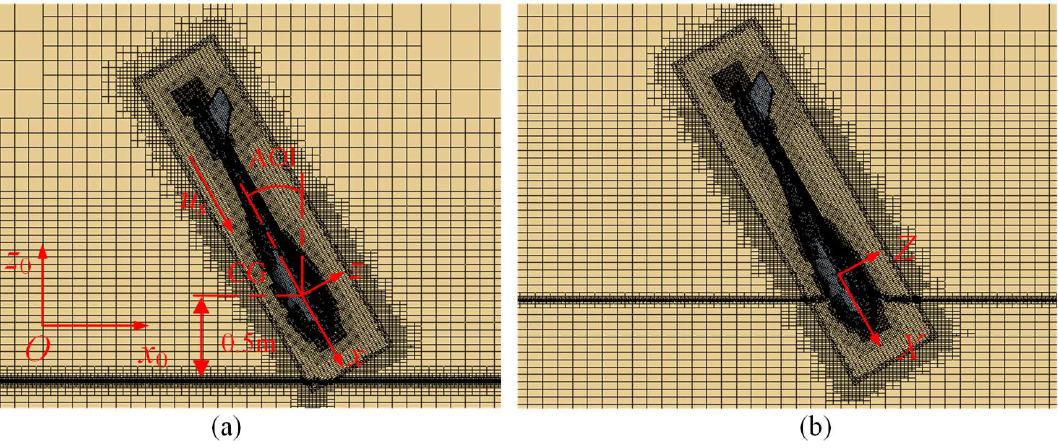
Figure 14. The sketch of the CFD mesh partition of ( a ) initial time and ( b ) running time of the oblique water entry. water